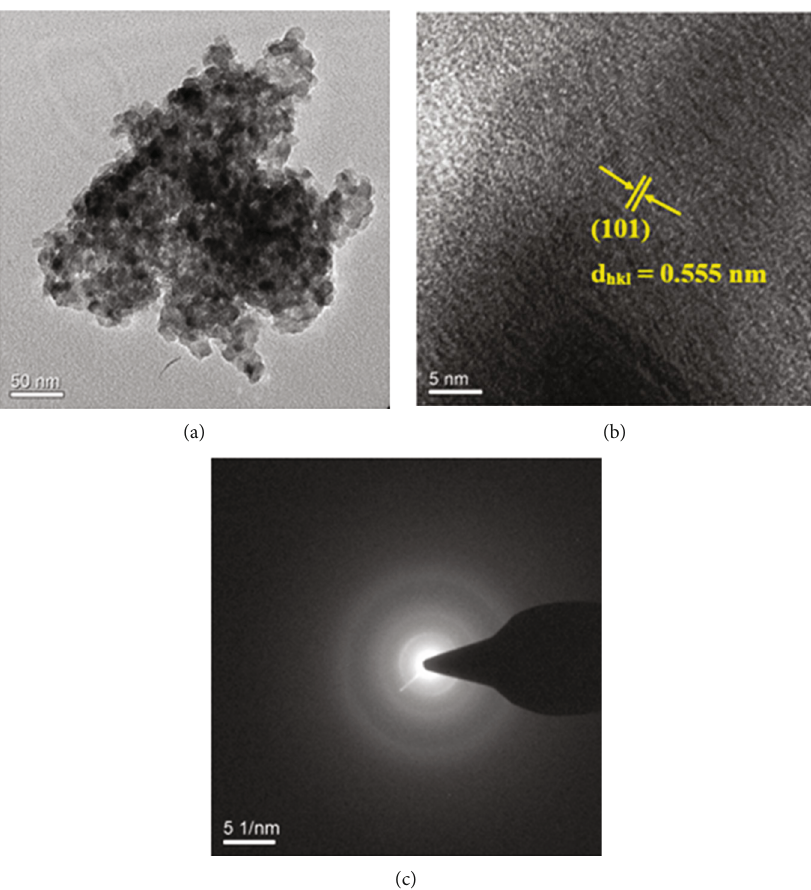
Figure 8: (a) TEM micrograph at 50 nm scale, (b) HRTM image, and (c) SAED pattern of TiO